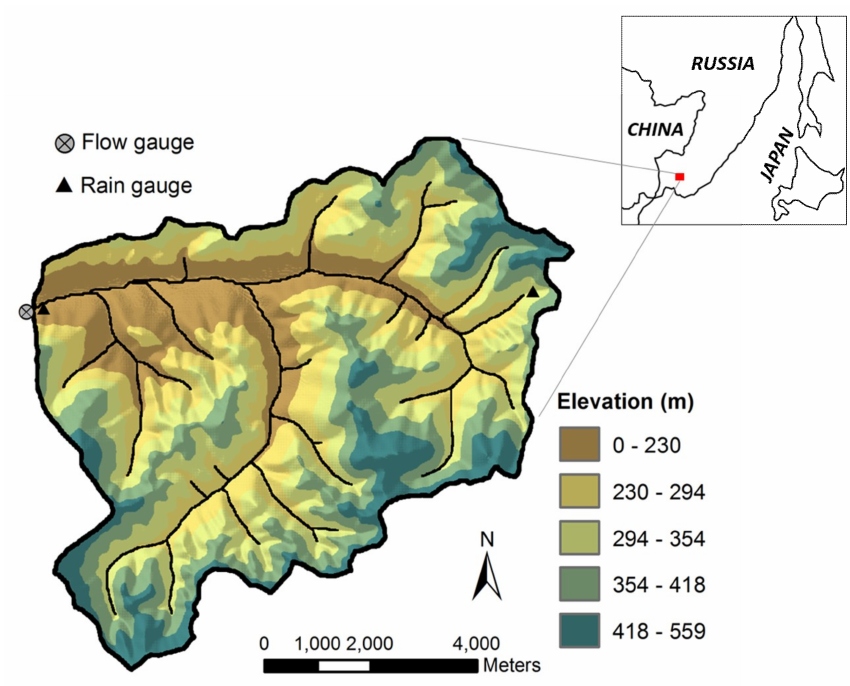
Figure 3. Topography and geographic location of the Komarovsky watershed in the far eastern Russia.